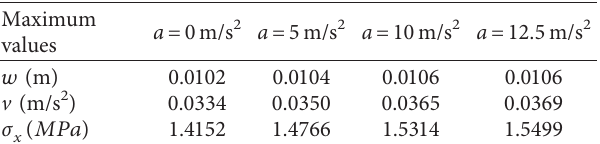
Figure 9: Dynamic deflections of the central point of the plate versus time for different acceleration a (m/s 2 ). (a) Deflection w versus time, (b) velocity v versus time, and (c) stress σ x versus time. Table 7: Maximum deflections, velocities, and stress of the plate central